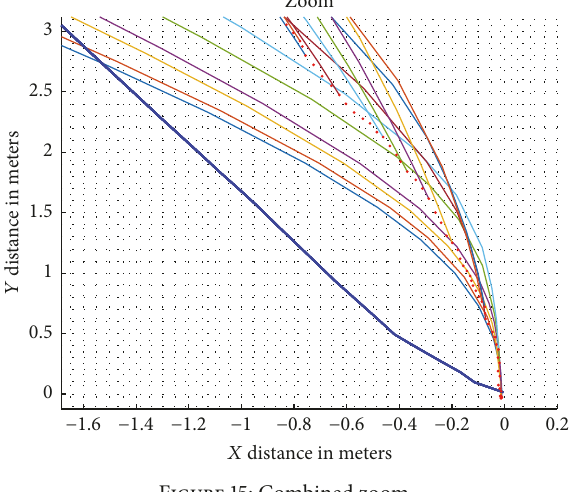
Figure 17: Average error.